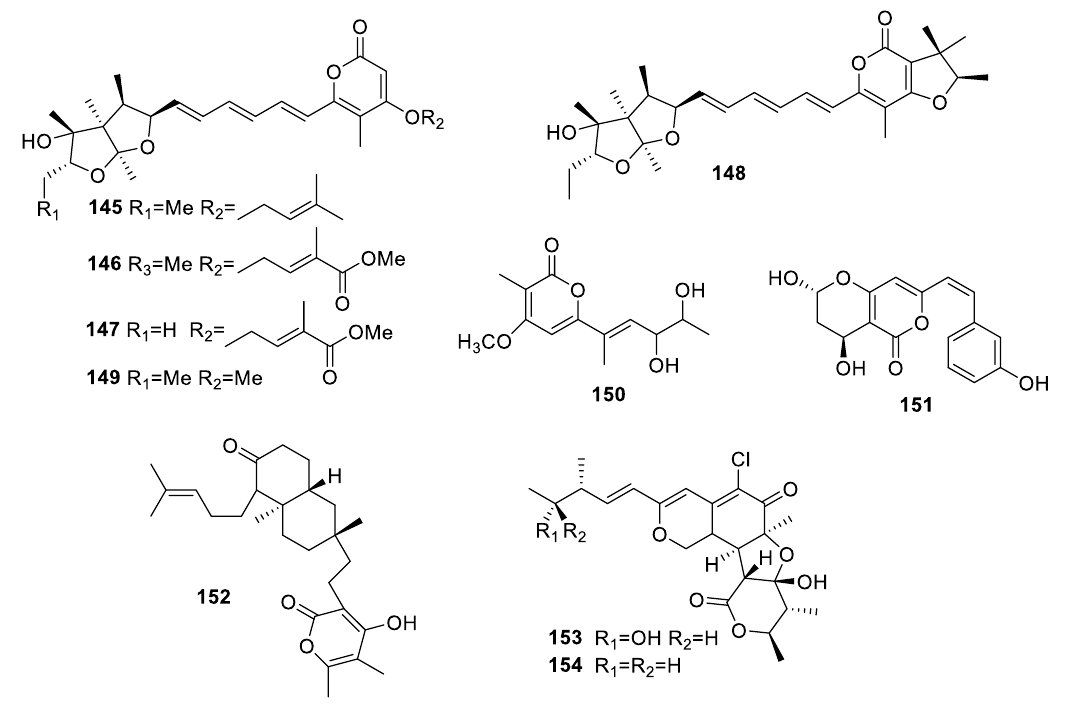
Figure 6. Chemical structures of simple pyranones ( 145 – 154 ). Benzopyrones Chromone derivatives hydroxylchromone ( 155 ) (Figure 7); ( 159 ) and isocoumarin congeners diaporthin ( 160 );